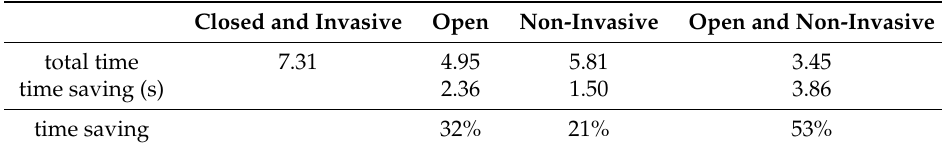
Table 6. Total response time comparison for proposed alternatives with open/closed architecture, and invasive/non-invasive authorization